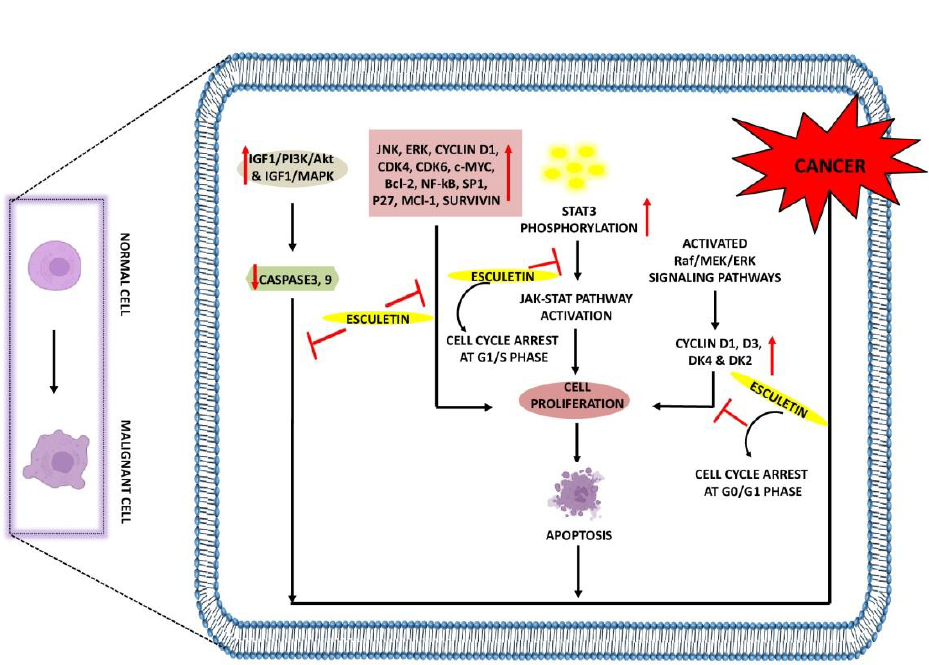
Figure 2 . Anti-cancer effects of esculetin: Esculetin downregulates the IGF1/PI3K/AKT, IGF1/MAPK, JNK, ERK, NF- κ B, P27, Survivin, and Bcl-2. Esculetin also inhibits cell proliferation by inhibiting the STAT3 phosphorylation and cyclin D1, D3, DK4, and DK2, leading to apoptosis and suppression of cancer. ↑ : Overexpression; ↓ : low expression; (cid:97) :